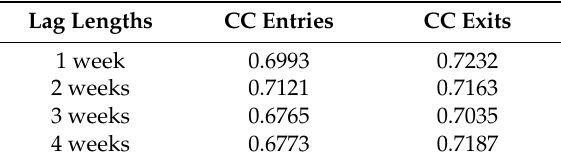
Table 1. Autocorrelation of lagged time series